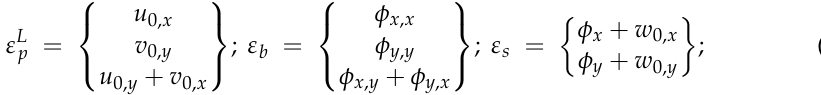
where, ε L denotes the linear membrane strain, ε b denotes bending strain, ε s denotes the P transverse-shear strains and ε NL denotes the nonlinear membrane-strain tensors, which are P further written as [19]: